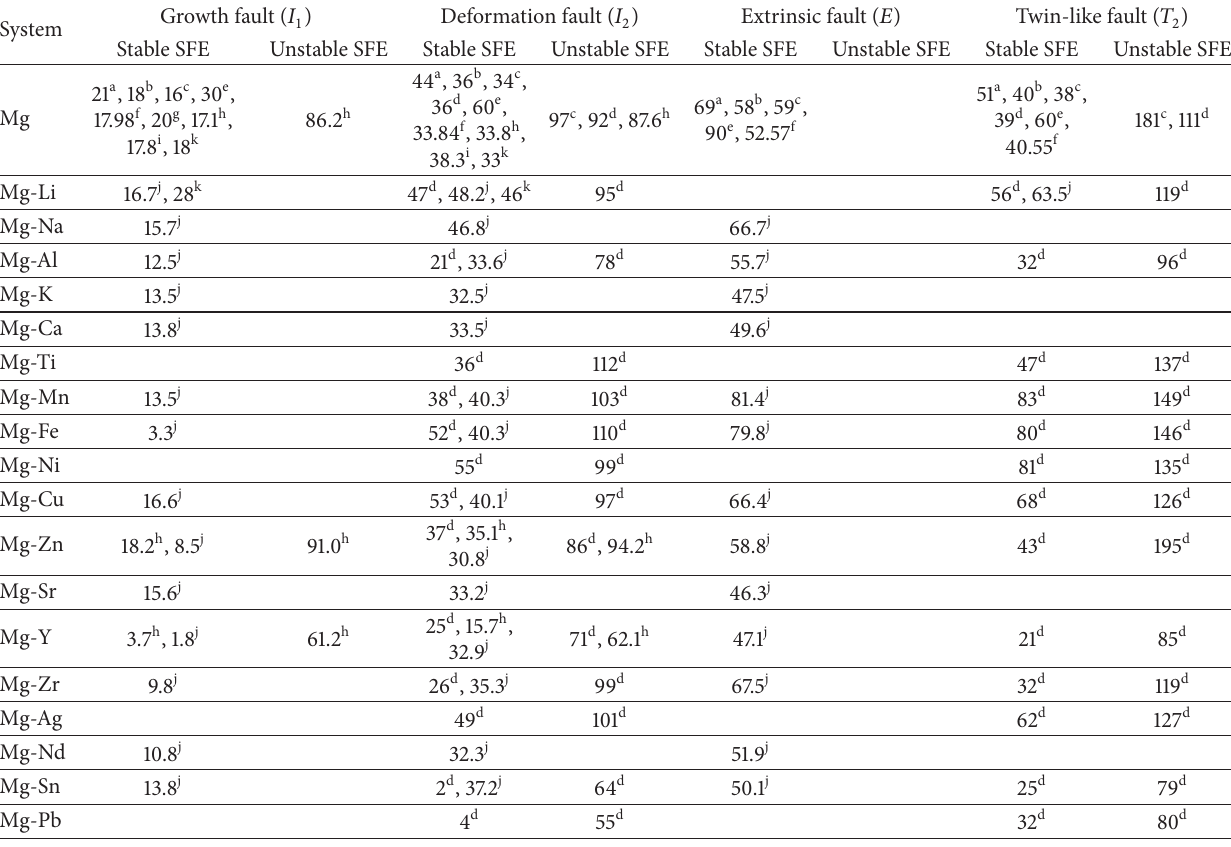
Table 1: Calculated stable SFE (mJ/m 2 ) and unstable SFE (mJ/m 2 ) for Mg and Mg alloys by DFT with different exchange-correlation